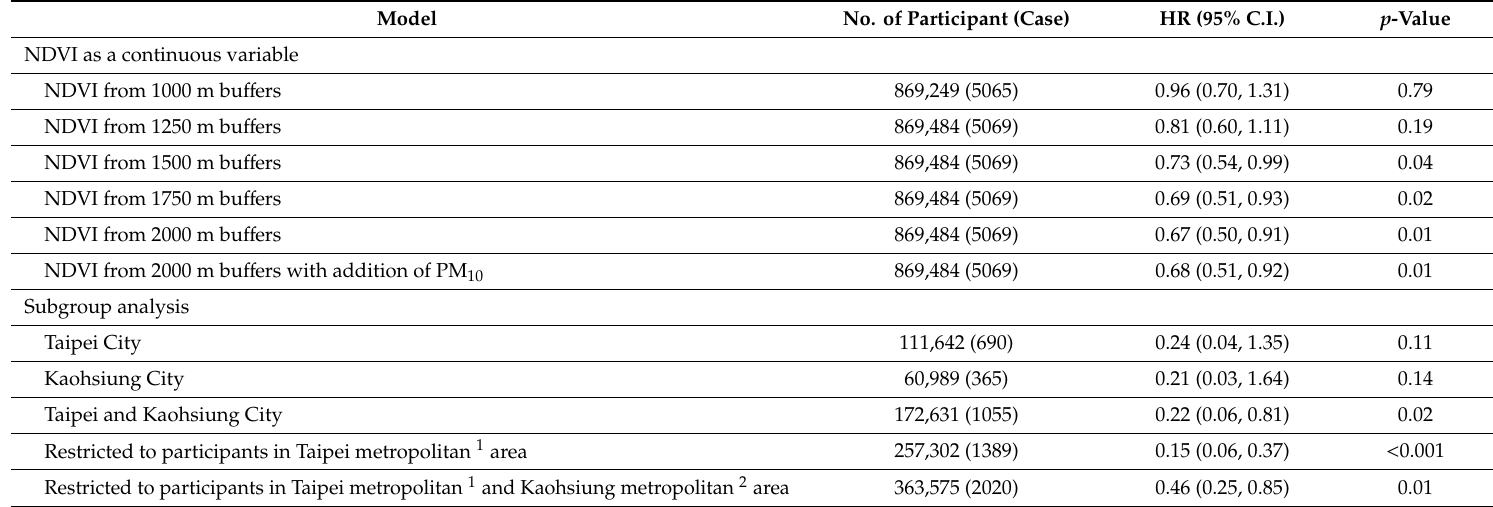
Table 3. Hazard ratios (HR) and confidence interval (C.I.) for NDVI in cox models in